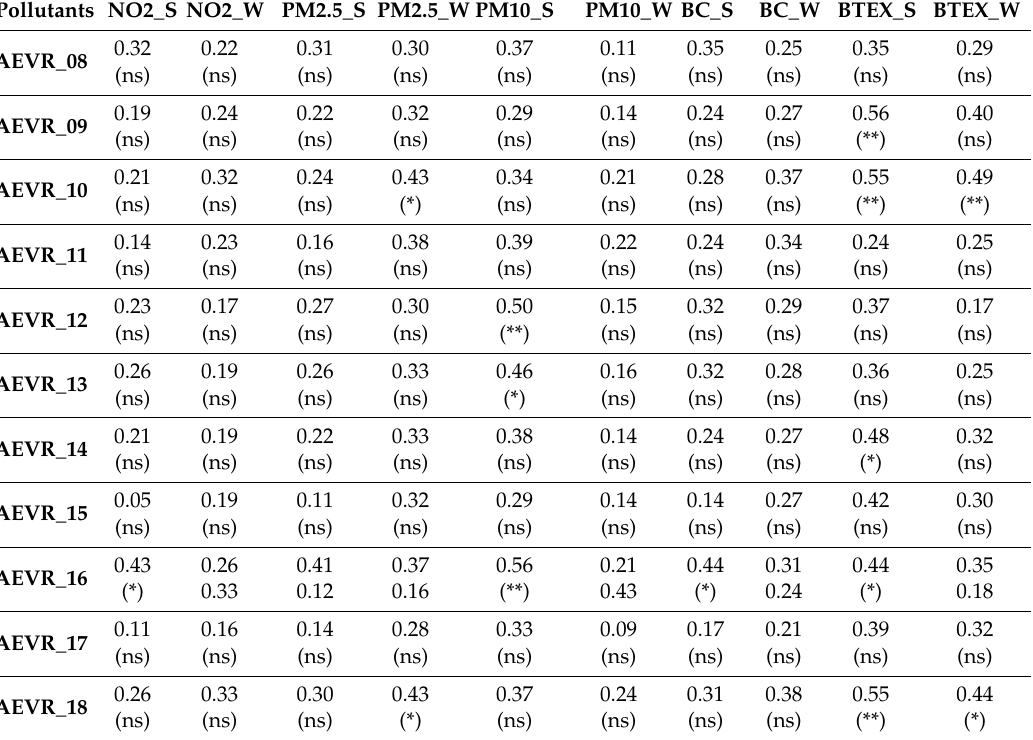
Table 3. Correlation of Asthma Emergency Visit Rate (AEVR) with pollutants in summer (_S) and winter (_W) with significance level 1 .